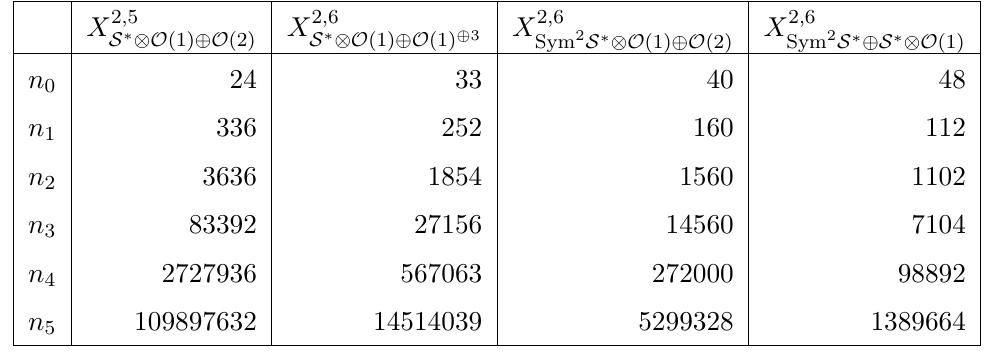
Table 2 . The triple intersection number and genus zero instanton numbers for CY 3-folds in Gr(2 ; m ).